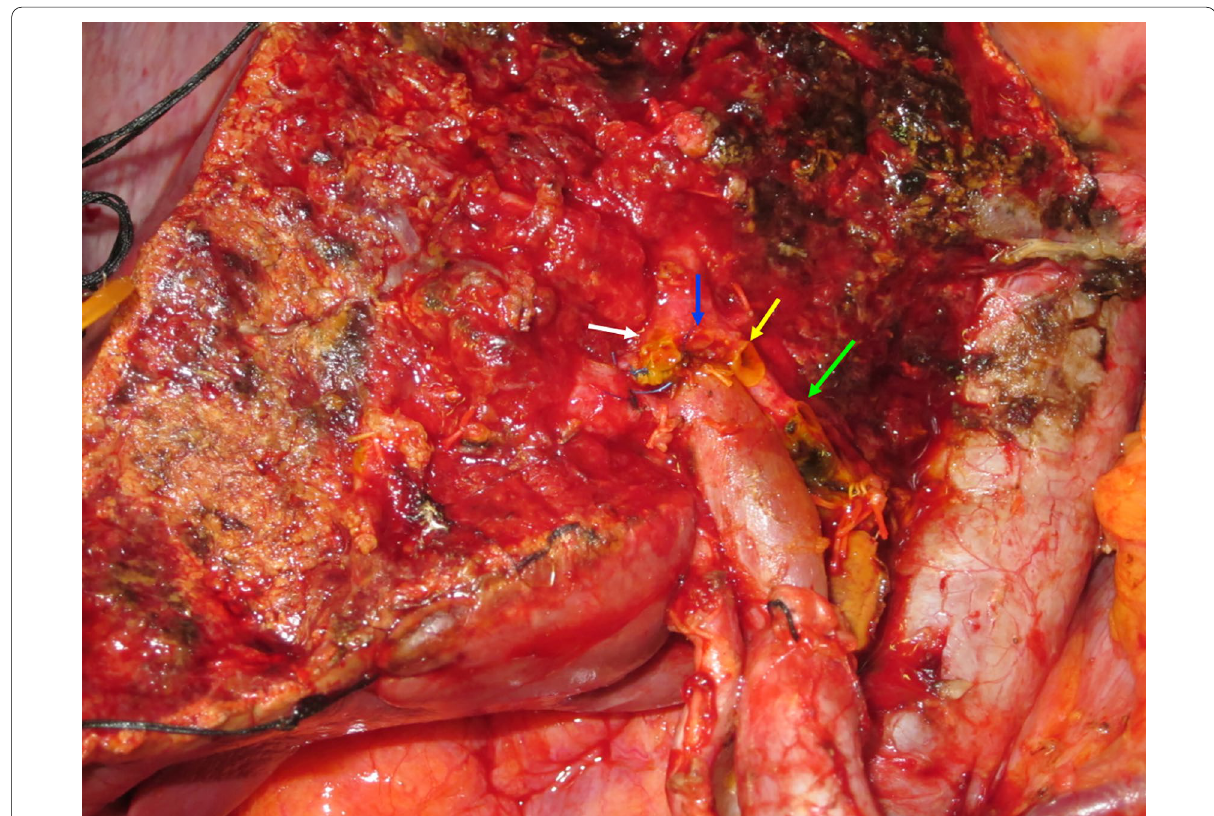
Fig. 3 Operation findings. This image shows the operative findings after extended left hepatectomy with resection of the caudate lobe, resection of the extrahepatic bile duct, and local-regional lymphadenectomy of the hepatoduodenal ligament. B5 (white arrow), B8a (blue arrow), B8c (yellow arrow), and right posterior bile duct (green arrow), were reconstructed by bilioenteric